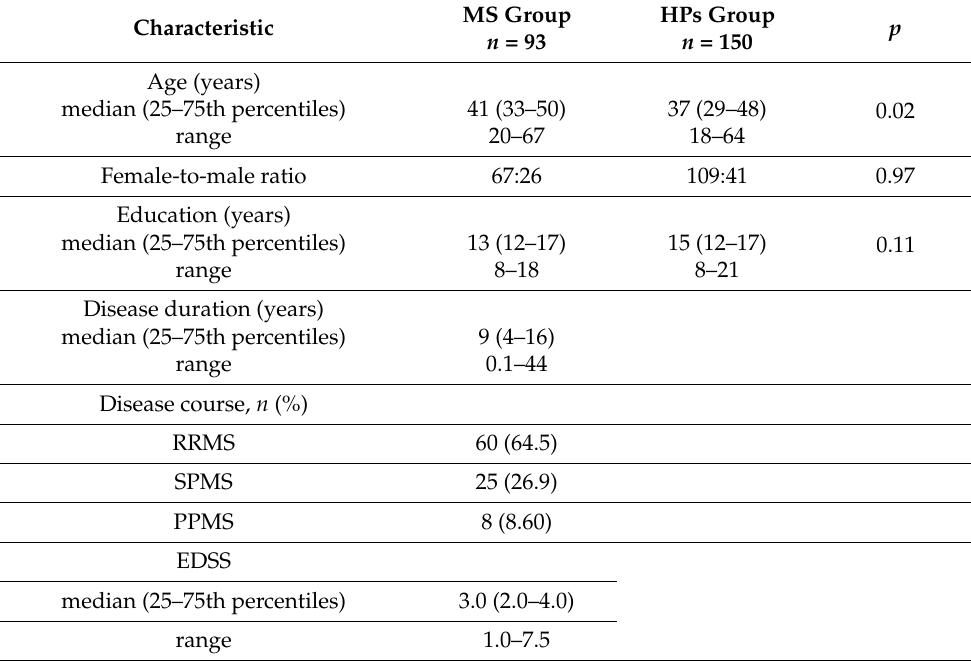
Table 1. Demographic and clinical characteristics of the study